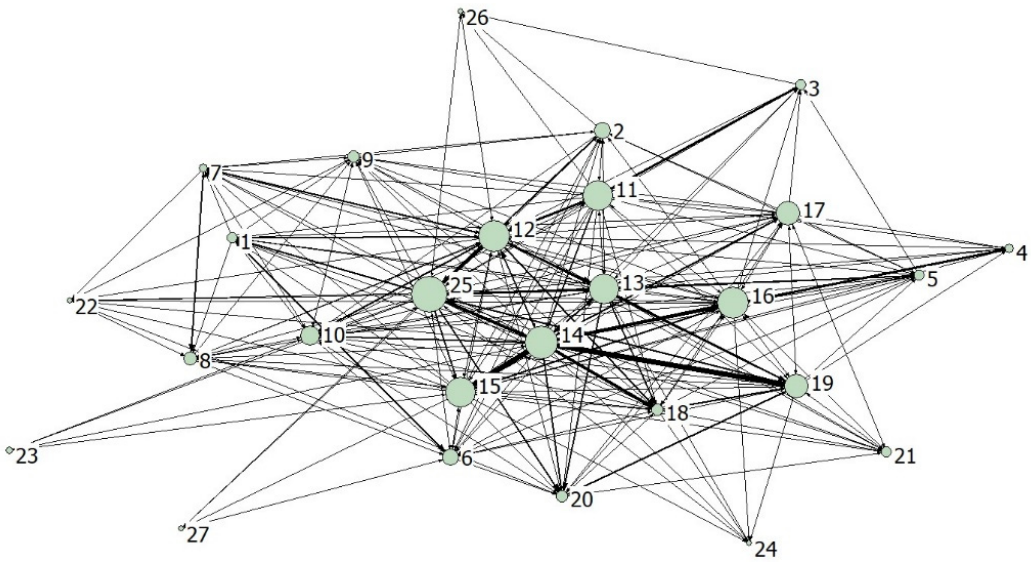
Figure 9. The correlation networks of NO x emissions between industrial sectors.